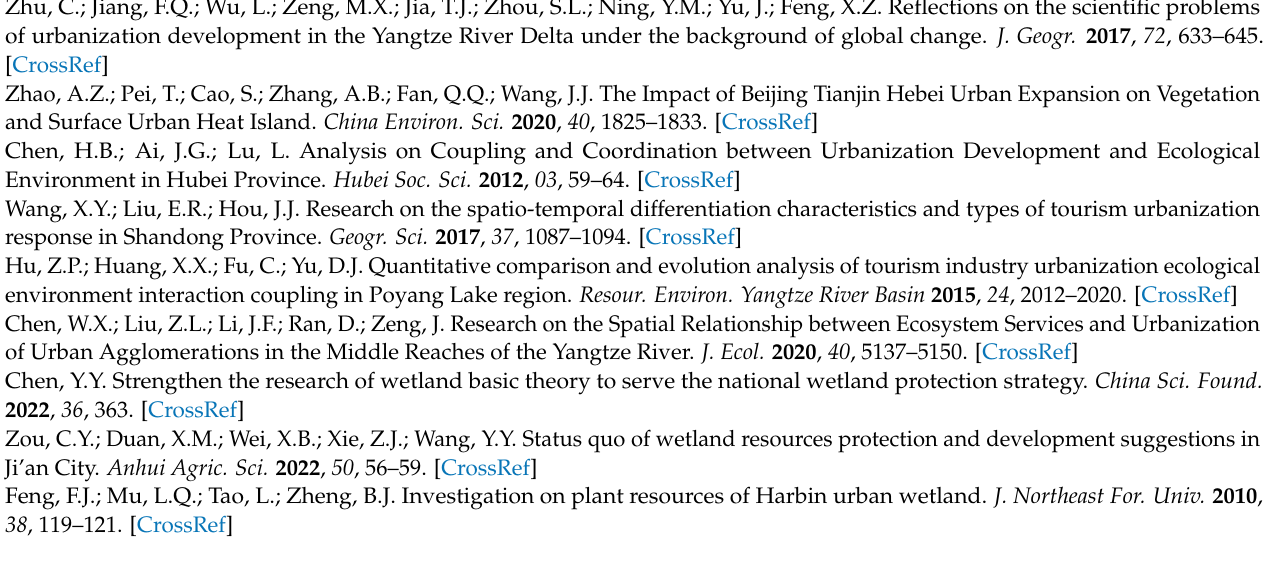
China.; Table S2: Community similarity of the samples with Ormosia pinnata ; Table S3: Community similarity of the samples with Dimocarpus longan ; Table S4: Community similarity of the samples with Ancistrocladus tectorius ; Table S5: Community similarity of the samples with Xylocarpus granatum ; Table S6: Community similarity of the samples with Sonneratia × gulngai . Table S7: Probability value of correlation between influencing factors and the species number and population size of rare and endangered plants,